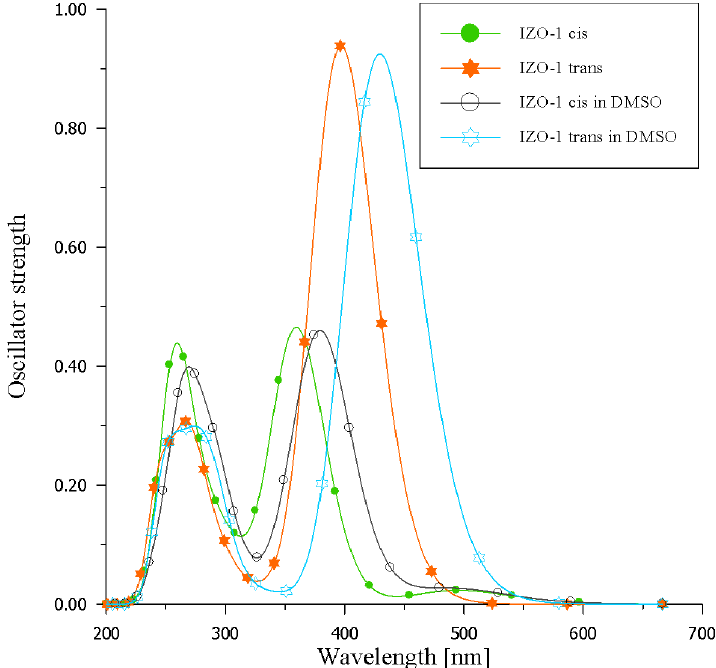
Fig. 4 Calculated UV-VIS spectra of